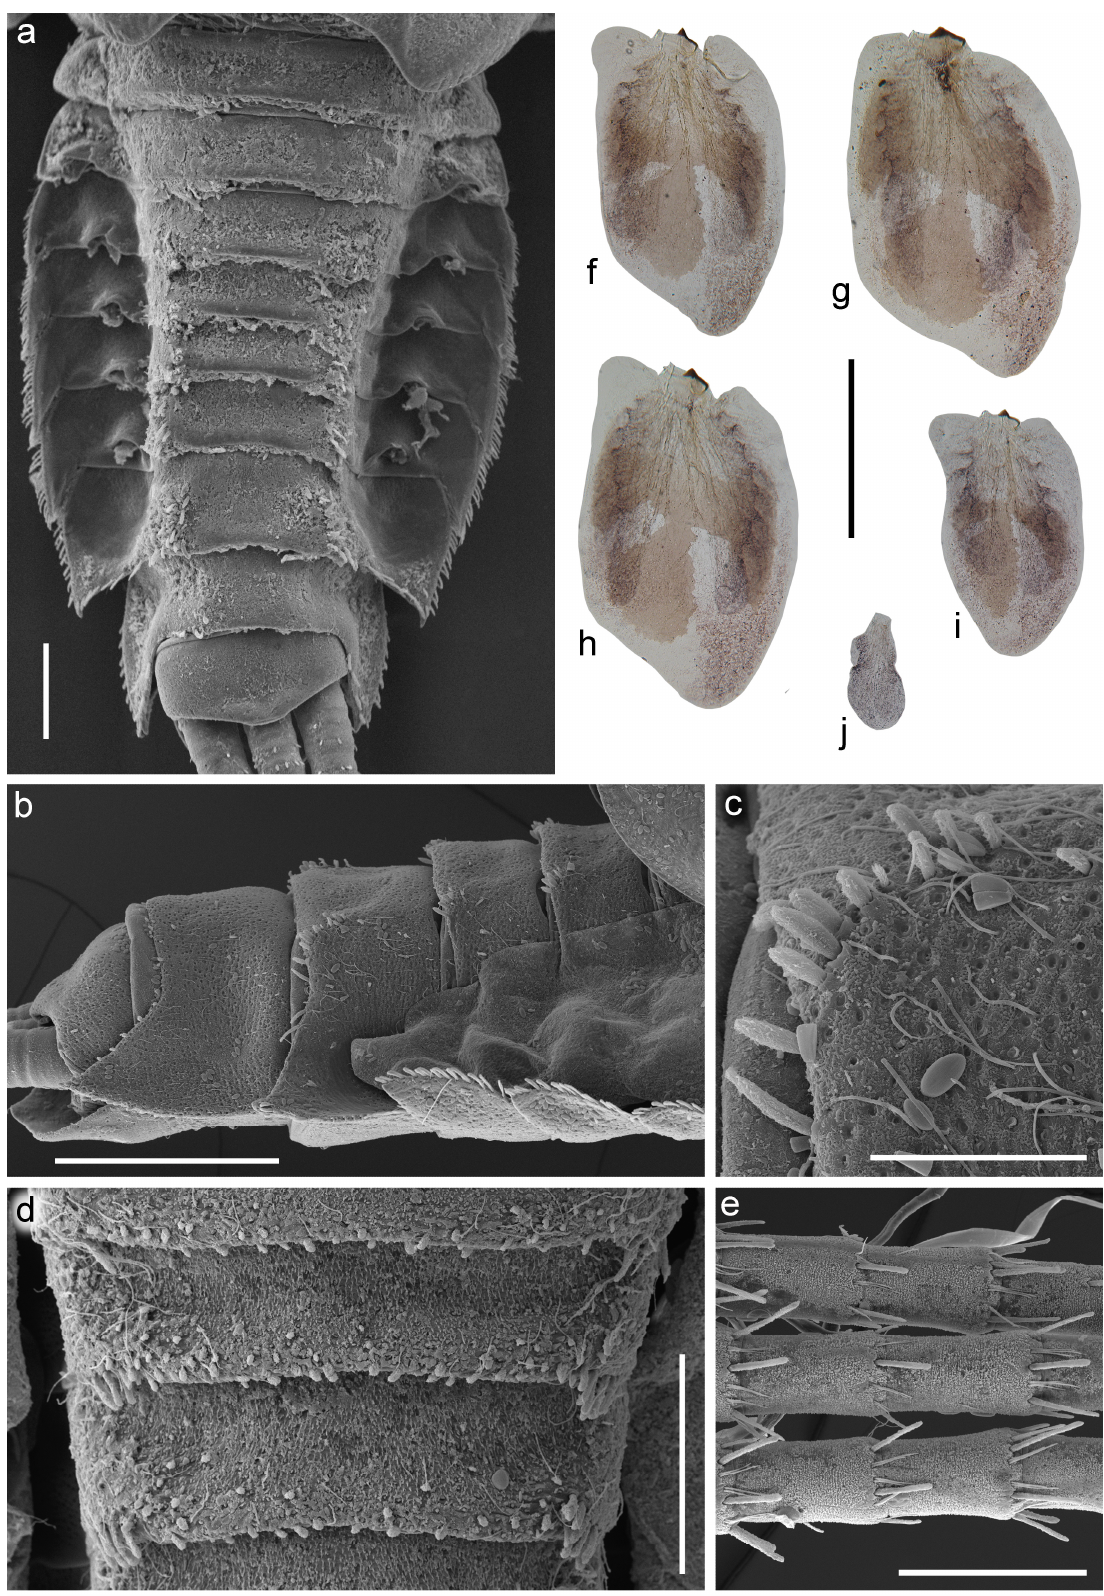
Figure 10. Larva of Torleya elissa (Jacobus, Zhou & McCafferty, 2009). ( a ) Abdomen, dorsal view, ( b ) terga VI–X, lateral view, ( c ) setae of tubercles on tergum VIII, ( d ) posterior margins of terga IV–VI, ( e ) caudal filaments, dorsal view, ( f – j ) gills III–VII. Scale bars: ( a )—0.3 mm, ( b , f – j )—0.5 mm, ( c )—0.1 mm, ( d )—0.25 mm, ( e )—0.2 mm.